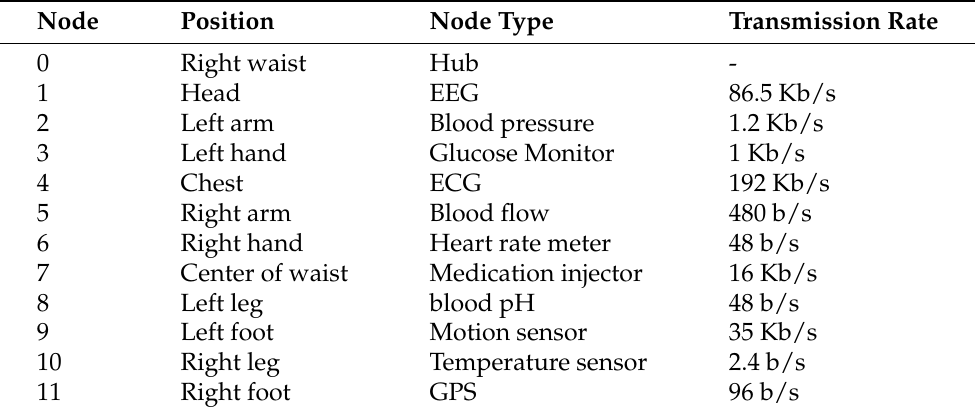
Table 3. WBAN sensors nodes, their positions and transmission